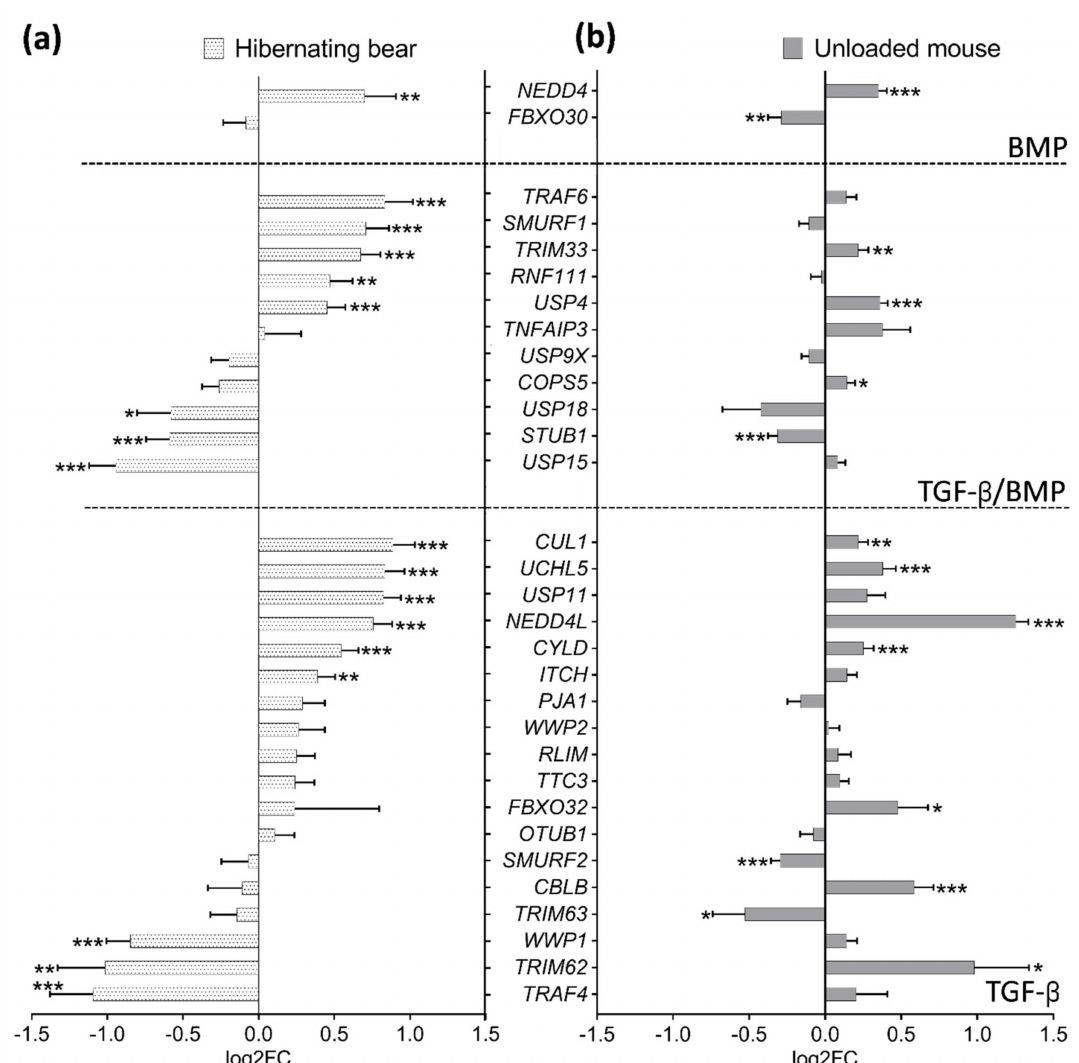
Figure 5. The gene expression pattern of muscle E3s/DUB enzymes involved in TGF- β and BMP pathway regulation differed in the atrophy-resistant brown bear muscle during hibernation compared to the atrophied muscle of the unloaded mouse. Genes expression level ( a ) in vastus lateralis muscle of active and hibernating brown bears ( n = 6 bears/season, the same individuals were sampled and analyzed in summer and winter, log2FC Winter/Summer, dotted white bars), and ( b ) in soleus muscle of control and unloaded mice ( n = 4 mice per condition, log2FC Unloaded/Control, gray bars). Data are expressed as log2FC ± lfcSE. Statistical significance is shown (* padj < |0.05|; ** padj < |0.01|; *** padj < |0.001|).